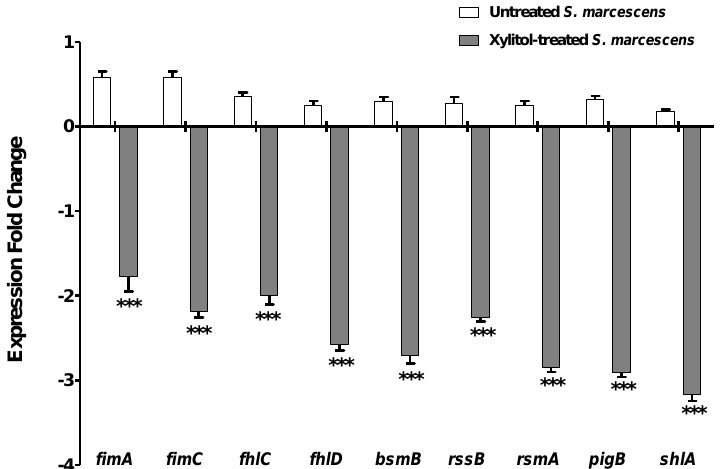
Figure 6. Xylitol decreased the expression of virulence genes of S. marcescens . RNA of xylitol-treated and untreated S. marcescens cultures was isolated to synthesize cDNA. cDNA was amplified and the change in the expression of each gene were normalized to the rplU gene as the housekeeping gene. The test was performed in triplicate. Xylitol (5%) significantly reduced the expression levels of fimA , fimC , flhC , flhD , bsmB , rssB , rsmA , pigP , and shlA genes. The data shown are the means ± standard errors. One-way ANOVA test followed by Dunnett’s Multiple Comparison test was used for statistical analysis. ***: p ≤